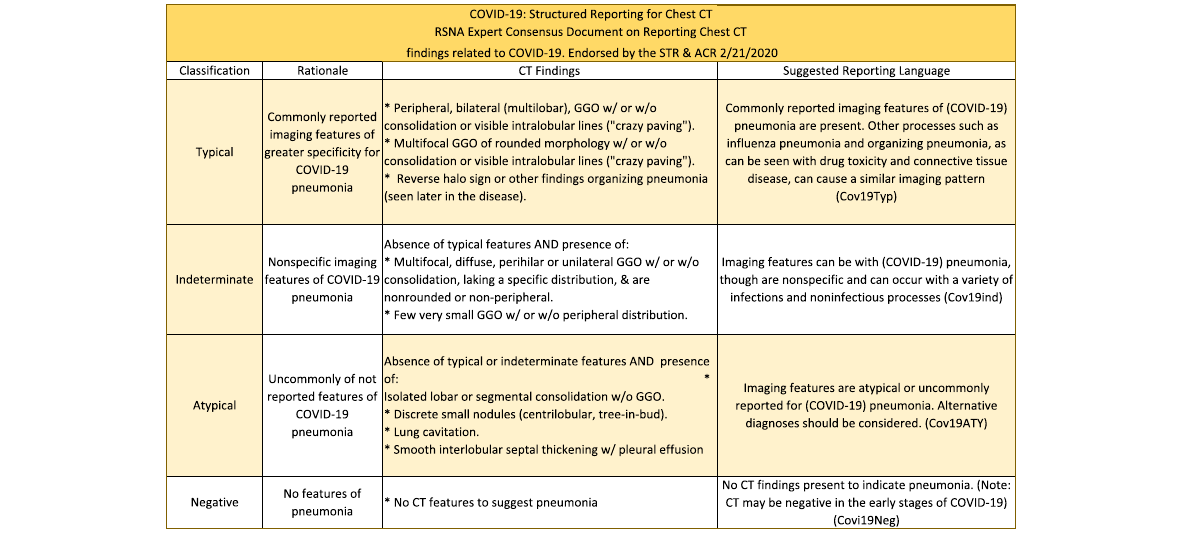
Fig. 8 American College of Radiology (ACR) Recommendations for the use of chest radiography and computed tomography (CT) for suspected COVID-19 infection